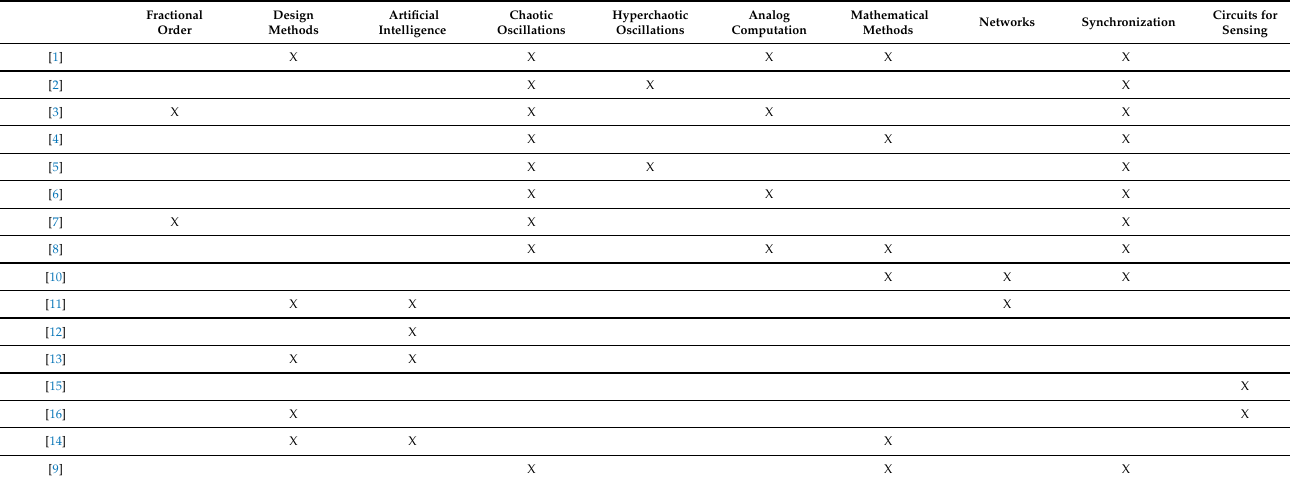
Table 1. Correlation matrix of the selected key topics. Fractional